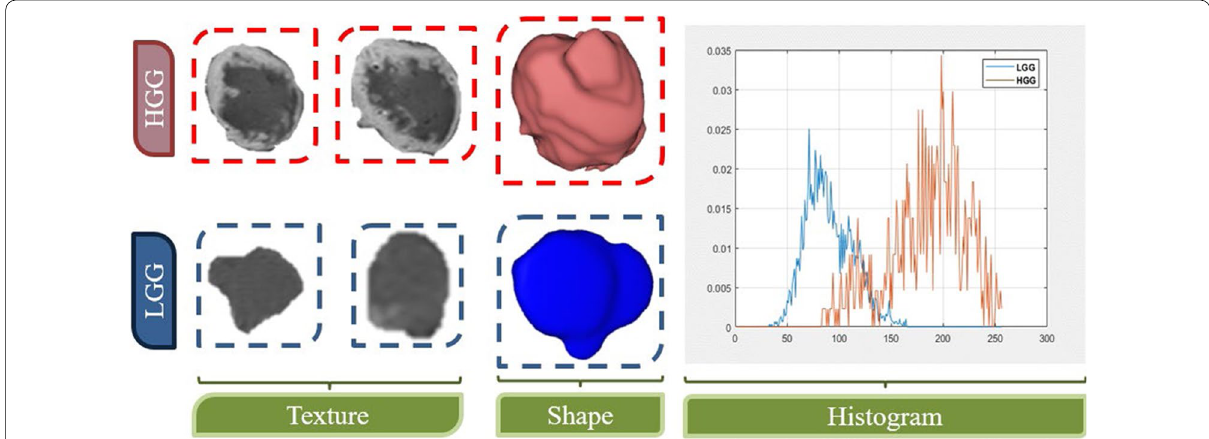
Fig. 4 Differences between three groups of features (texture, shape, and histogram) extracted from two glioma subjects with different grades (HGG and